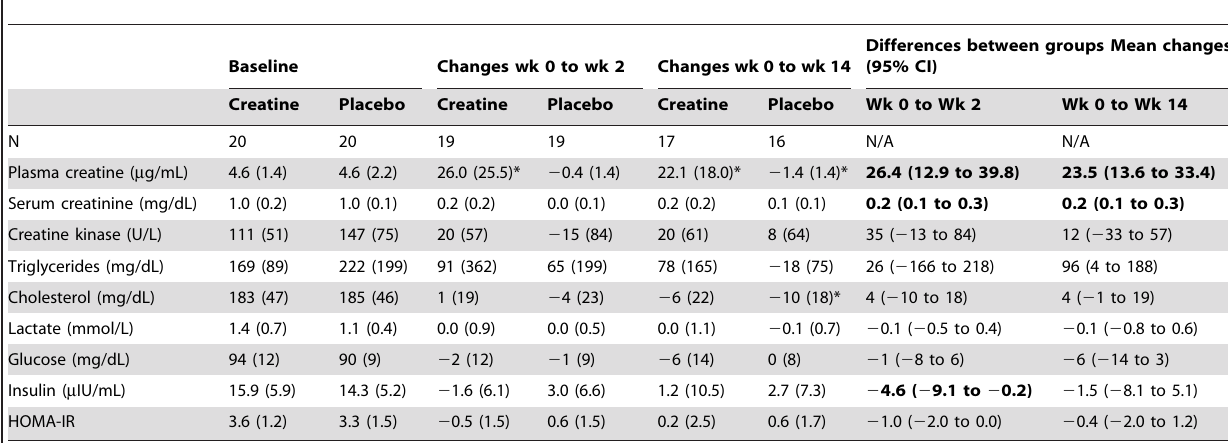
Table 4. Safety and Biochemical Measurements at Baseline and Changes on